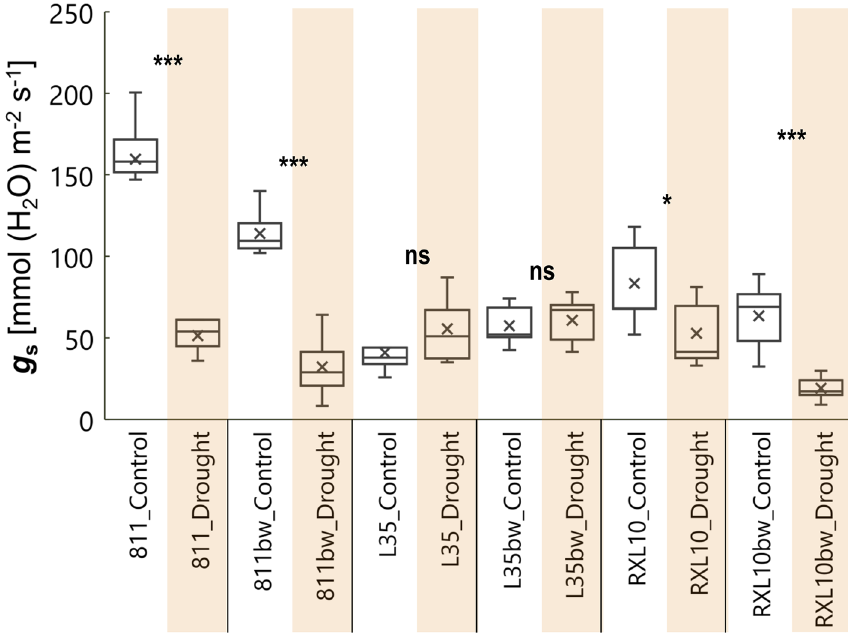
Figure 3. Box plot of leaf stomatal conductance ( g s ) by glaucous (811, L35, RXL10) and non-glaucous (811bw, L35bw, RXL10bw) near-isogenic lines of rye and by soil water status (control or drought). The statistically significant differences between the means in control and drought were verified for P ≤ 0.001(***), P ≤ 0.01(**), P ≤ 0.05(*) according to Student’s test. ns not